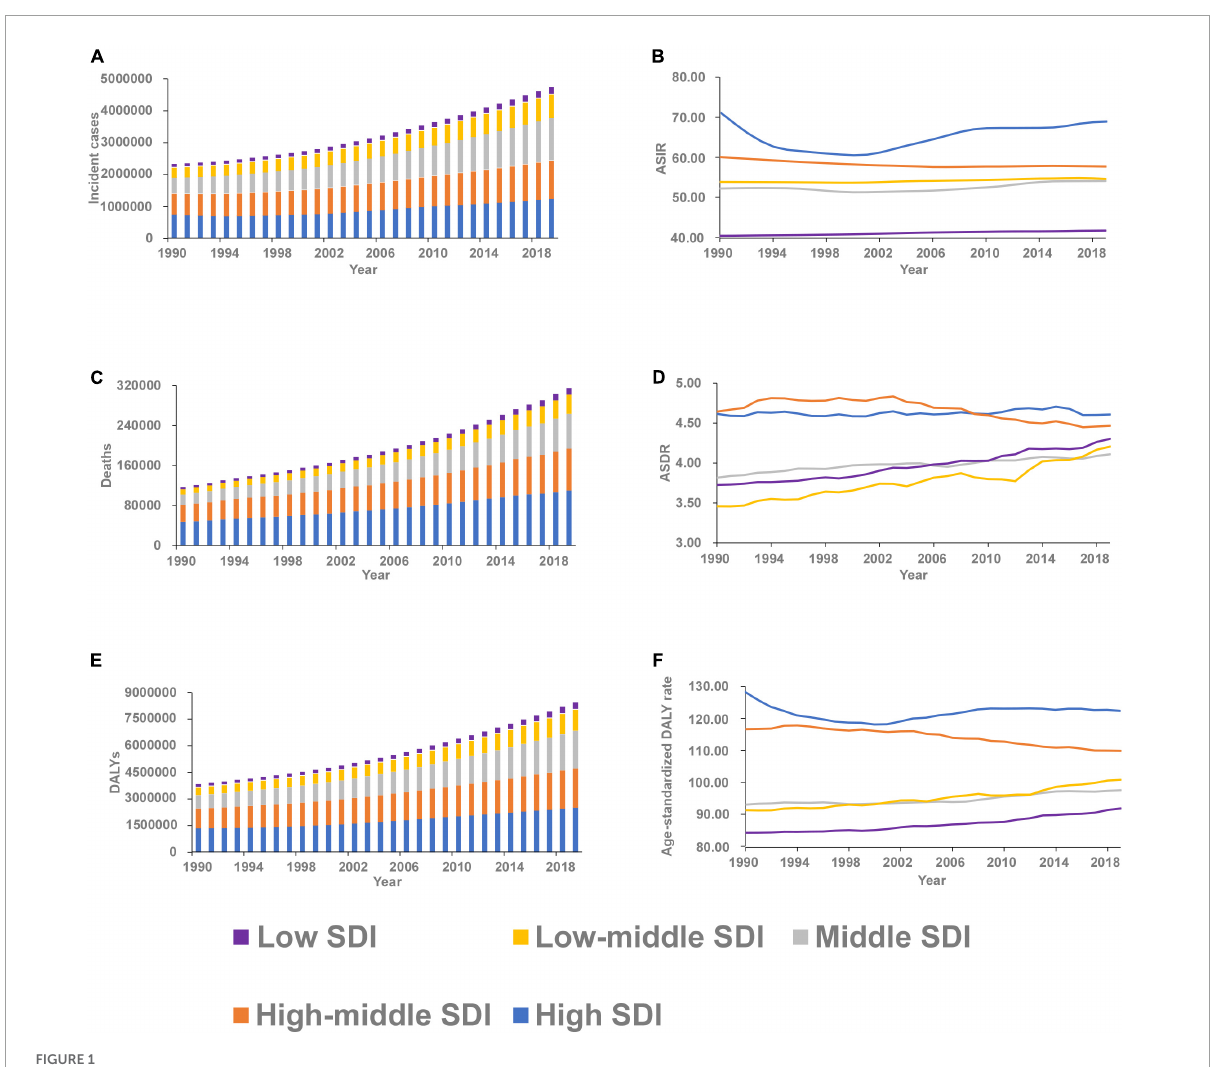
FIGURE1 The burden and trend of atrial fibrillation in five socio-demographic Index (SDI) quintiles from 1990 to 2019. (A) Incident cases. (B) Age-standardized incidence rate (ASIR). (C) Deaths. (D) Age-standardized death rate (ASDR). (E) Disability-adjusted life-years (DALYs). (F) Age-standardized DALY